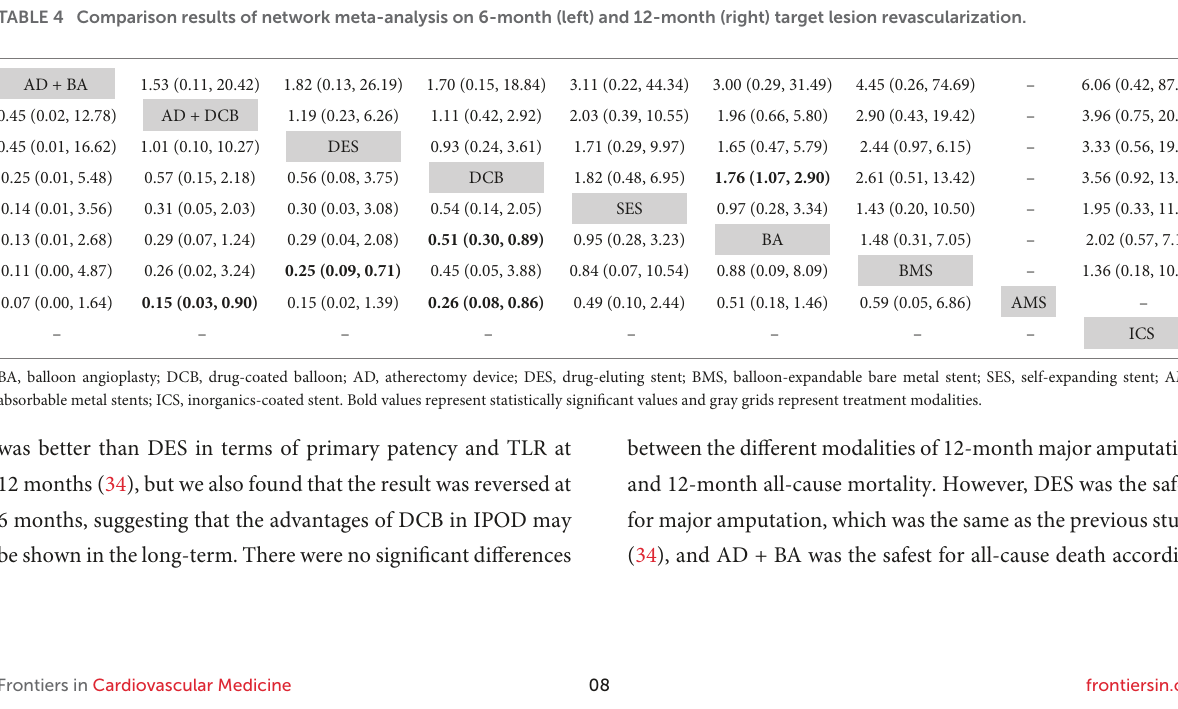
TABLE 4 Comparison results of network meta-analysis on 6-month (left) and 12-month (right) target lesion revascularization.